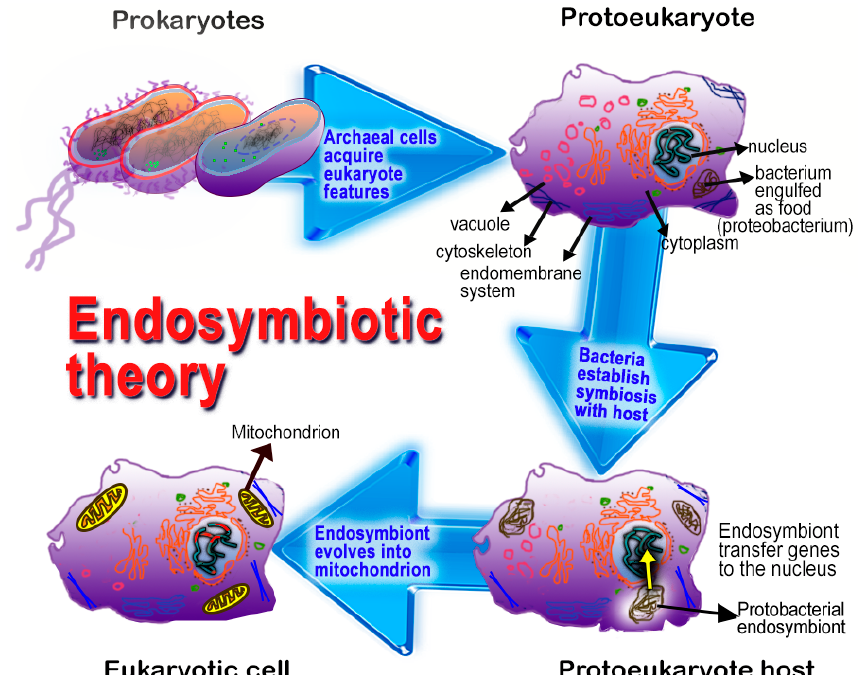
Figure 5. A summary of the major theory, the Endosymbiotic Theory, that explains the evolution of mitochondria as they exist in current-day eukaryotic cells. Accordingly, prokaryotic “cells” evolved features of eukaryotes over millions of years. An example of one major development, as it relates to the current review, is the phagocytosis of proteobacteria by prokaryotes; the bacteria were initially engulfed as nutrients by their digestion in intracellular granules. Eventually, the engulfed bacteria endosymbiont sent much of its genetic material to the nucleus of the host while the symbiont gradually